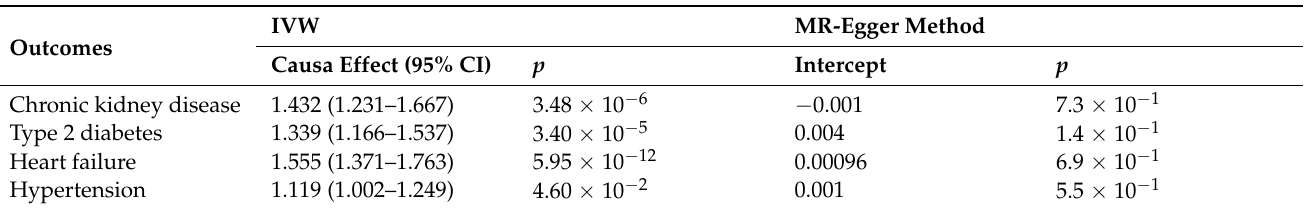
Table 2. Mendelian randomization estimates of the associations from whole body water mass on common edematous diseases. IVW, inverse variance